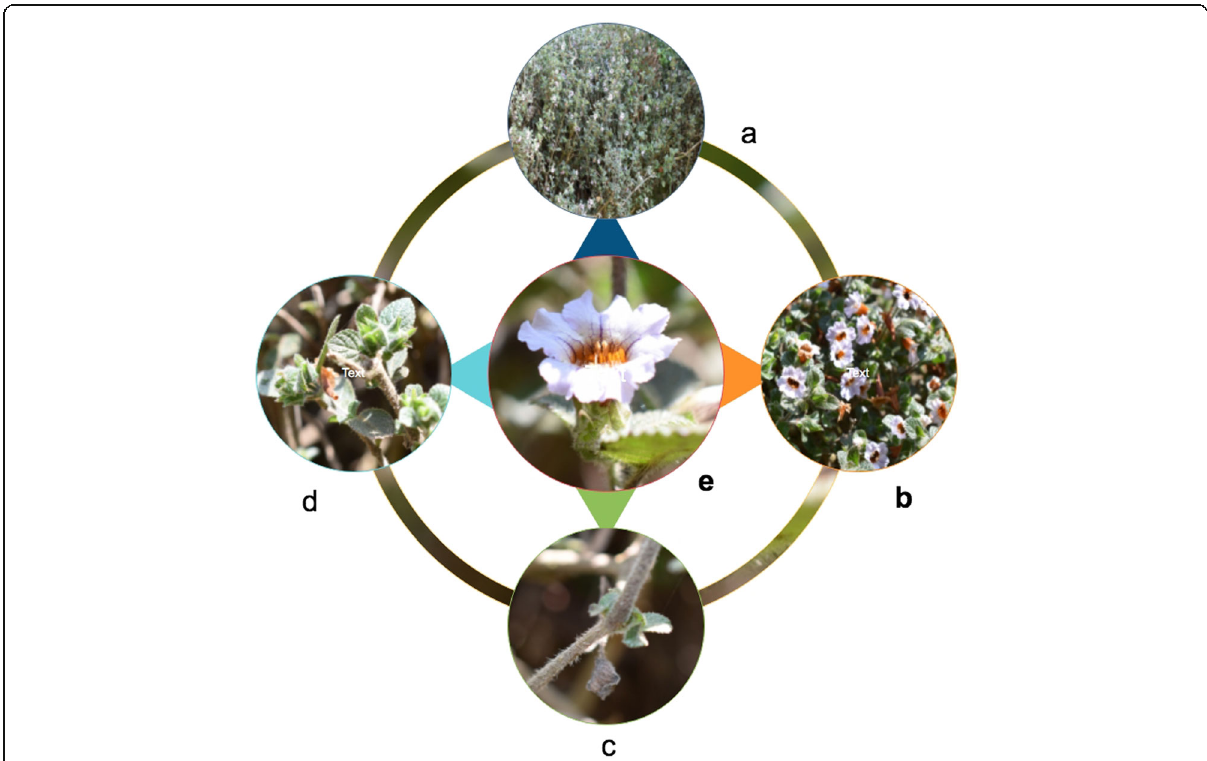
Fig. 2 Salient botanical features of Neelakurinji ( Strobilanthes Kunthianus Nees T Anders). a Full-grown bushy shrub, b flower-bearing shrub, c stems with glabrous to sparsely pubescent barks, d elliptic-ovate with stout hairs with subentire to prominently serrated leaves, e pale blue or pale lilac or mauve flower (Photographs are not in scale) ( Source : unpublished photographs of Soumen Bera)